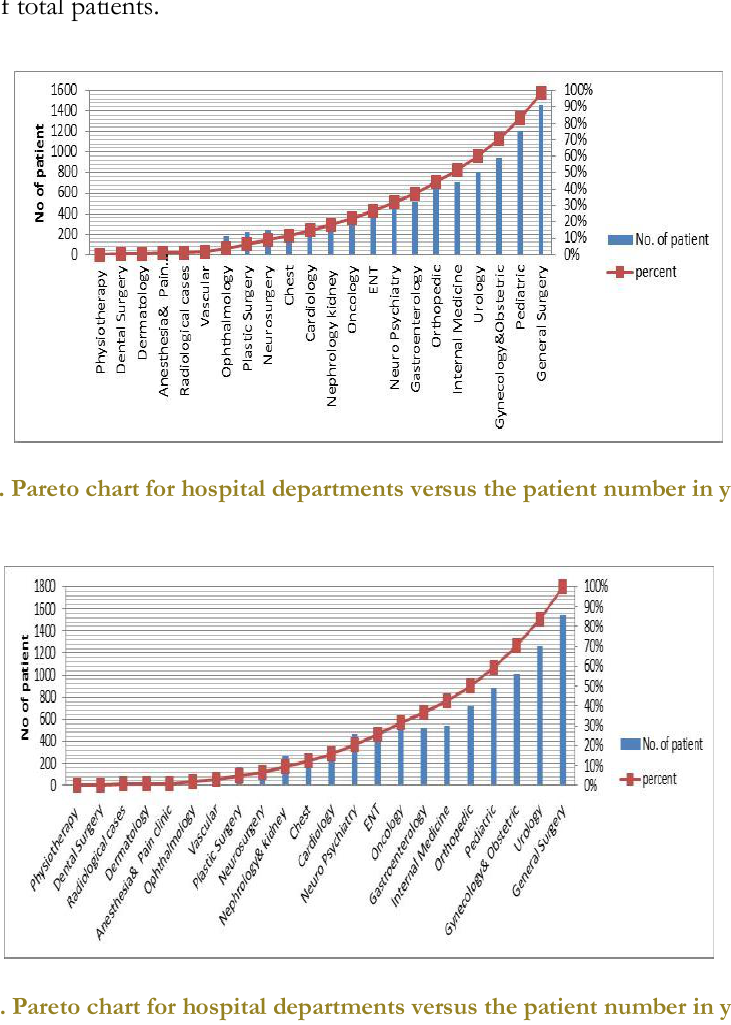
Fig. 5. Pareto chart for hospital departments versus the patient number in year 2011.